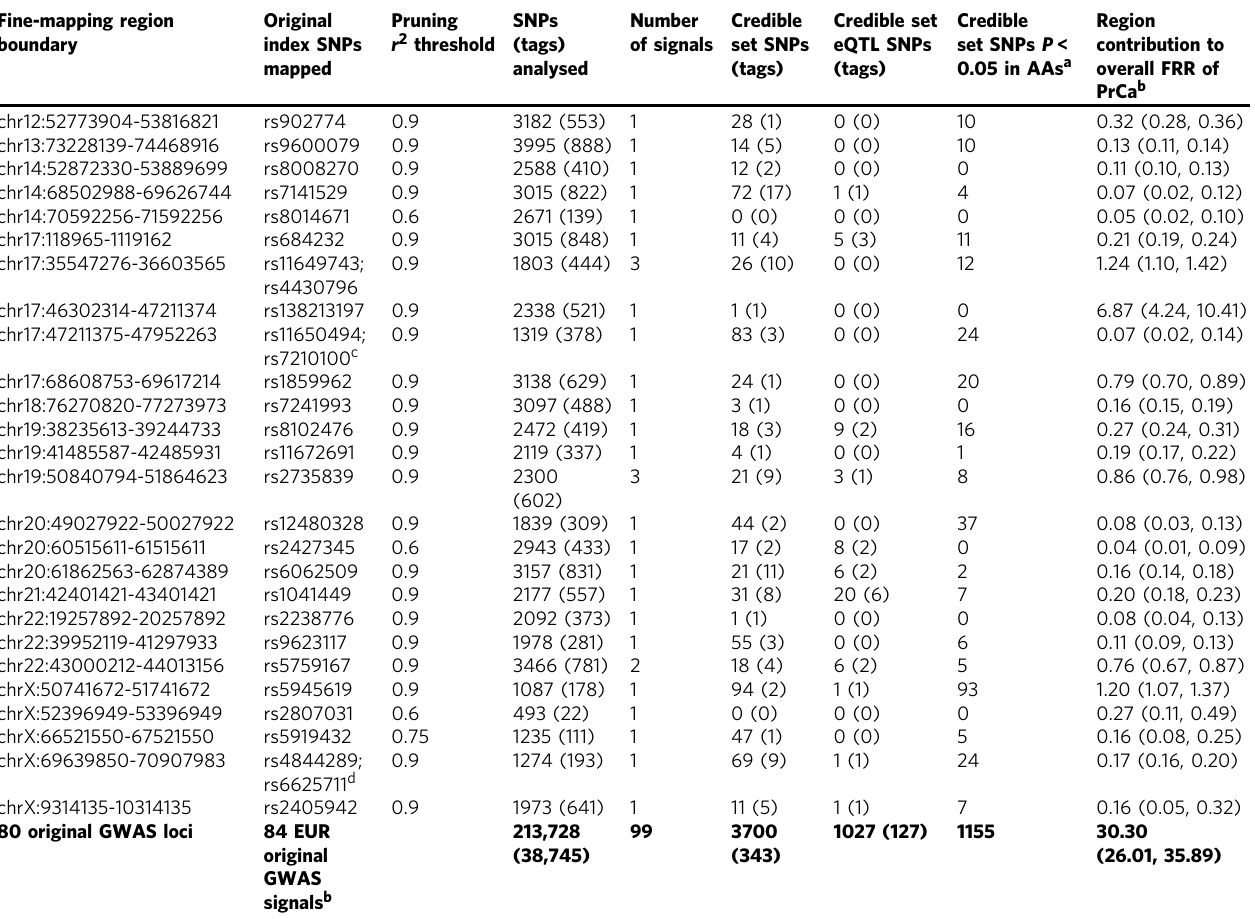
Table 3 Overview of fi ne-mapping results by region for regions 55 – 80 of the 80 regions fi ne-mapped, and summary results across all 80 regions Fine-mapping region